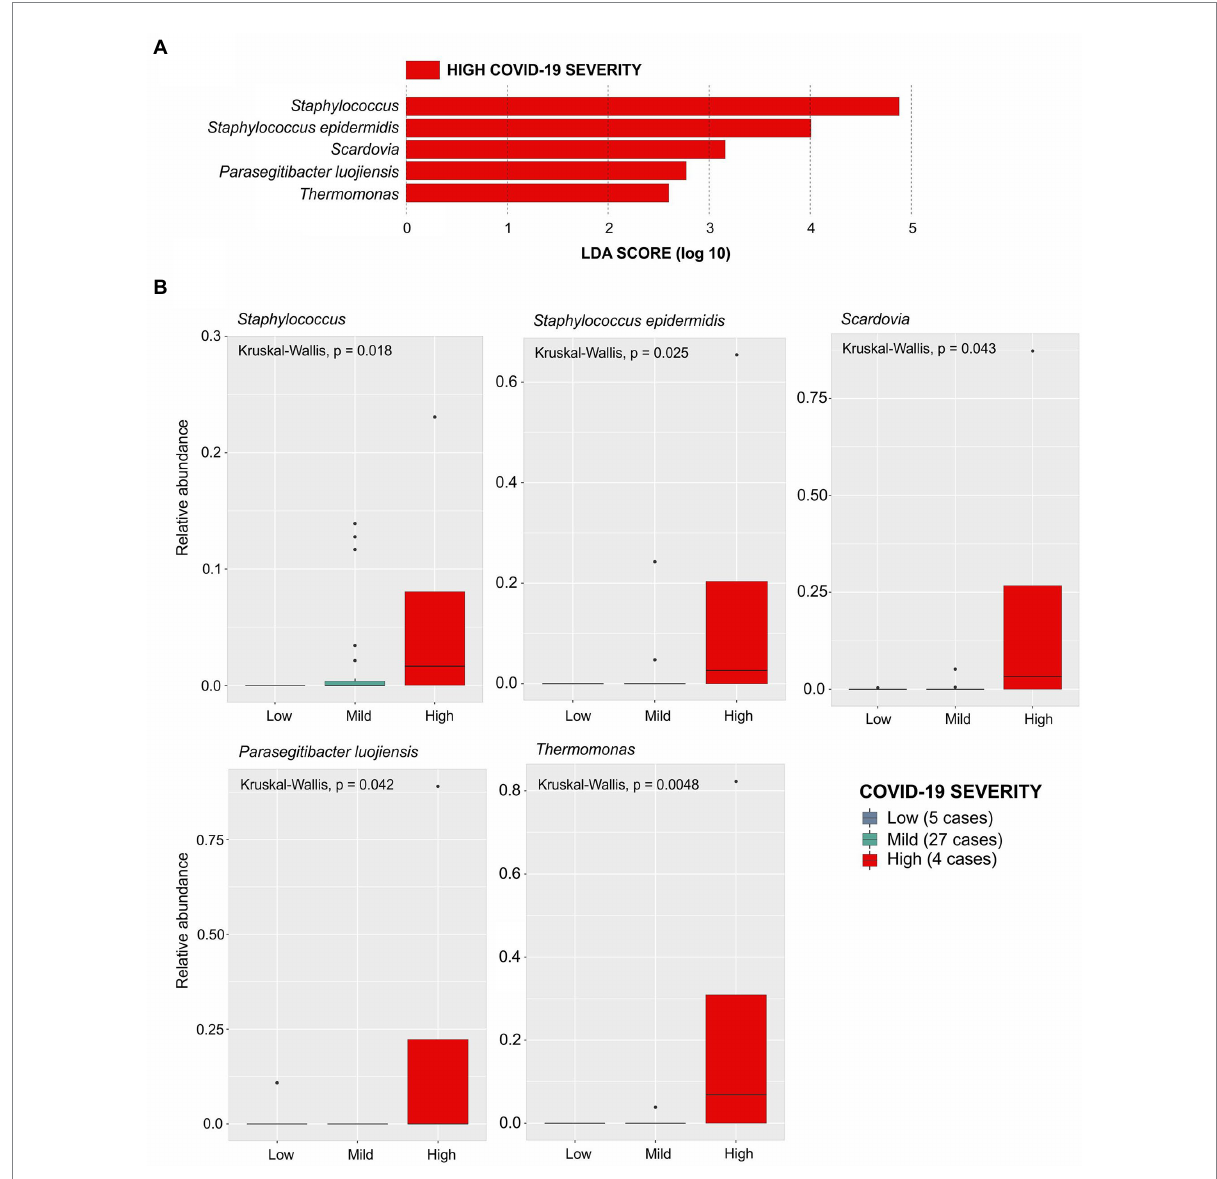
FIGURE 4 Linear Discriminative Analysis - Effect Size (LDA-EfSe) to identify bacterial taxa associated with COVID severity in BC + CV+ patients: (A) Bacterial taxa associated with disease severity; (B) Histograms showing the comparison of the relative abundance of each bacterial taxa between the BC + CV+ patients discriminated with respect to COVID severity (low, mild, or high). Comparisons were carried out using the Kruskal-Wallis test, and the p -values are presented for each